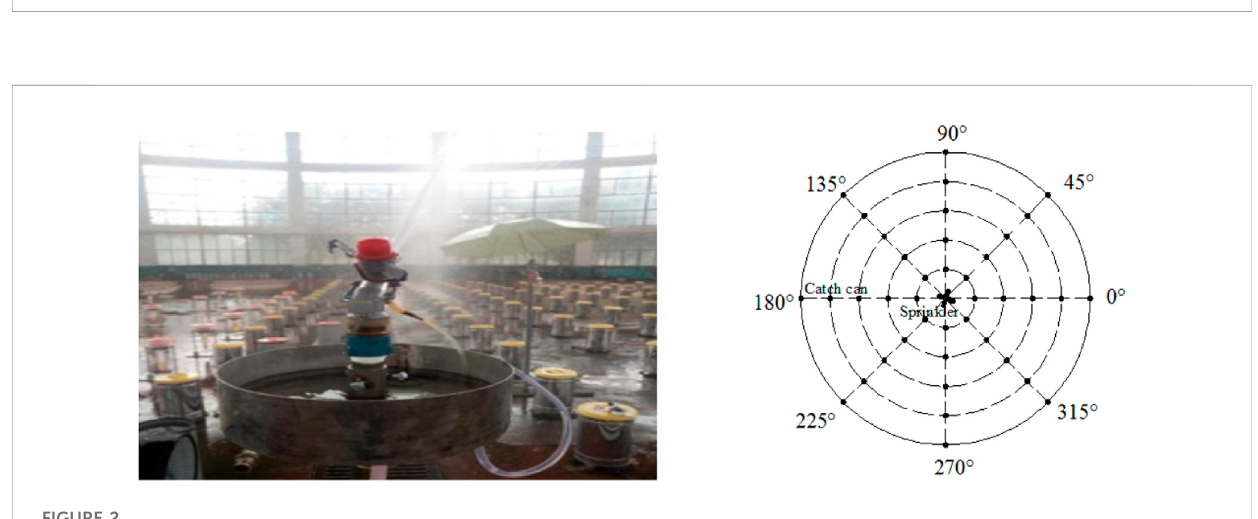
FIGURE 2 Schematic and pictorial view of sprinkler